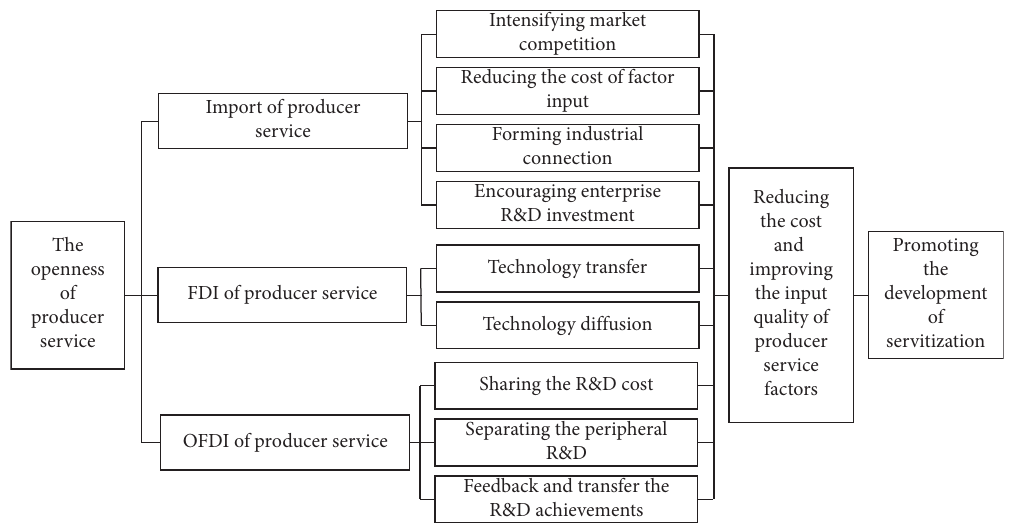
Figure 1: The impact mechanism of producer services openness on the development of